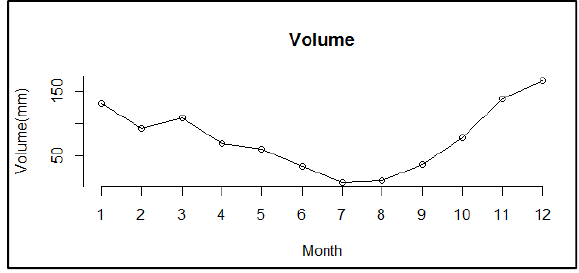
Figure 10. The volume on a monthly basis, averaged for the period of record, for Station 04.